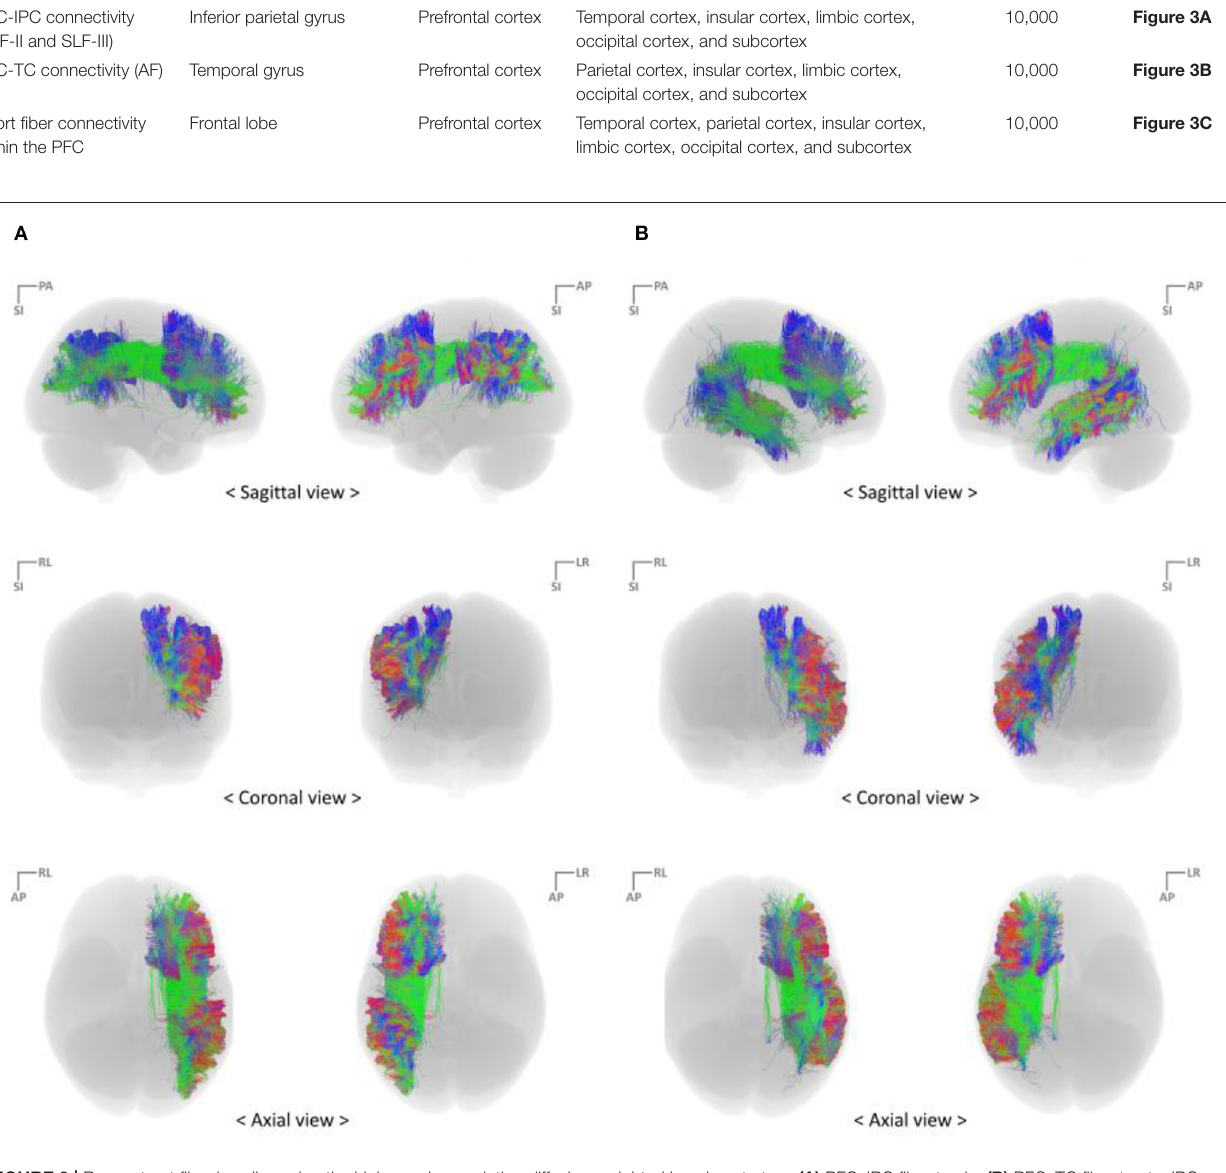
FIGURE 3 | Reconstruct fiber bundles using the high angular resolution diffusion-weighted imaging strategy (A) PFC–IPC fiber tracks (B) PFC–TC fiber tracts. IPC, inferior parietal cortex; PFC, prefrontal cortex; TC, temporal